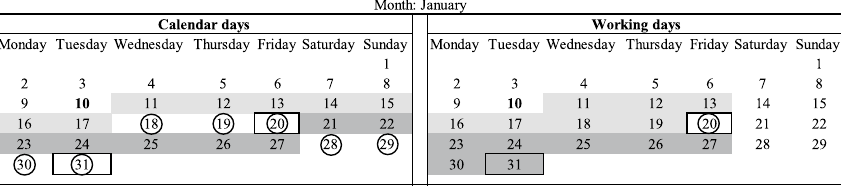
Fig. 6 Example calendar—working days. Source : own